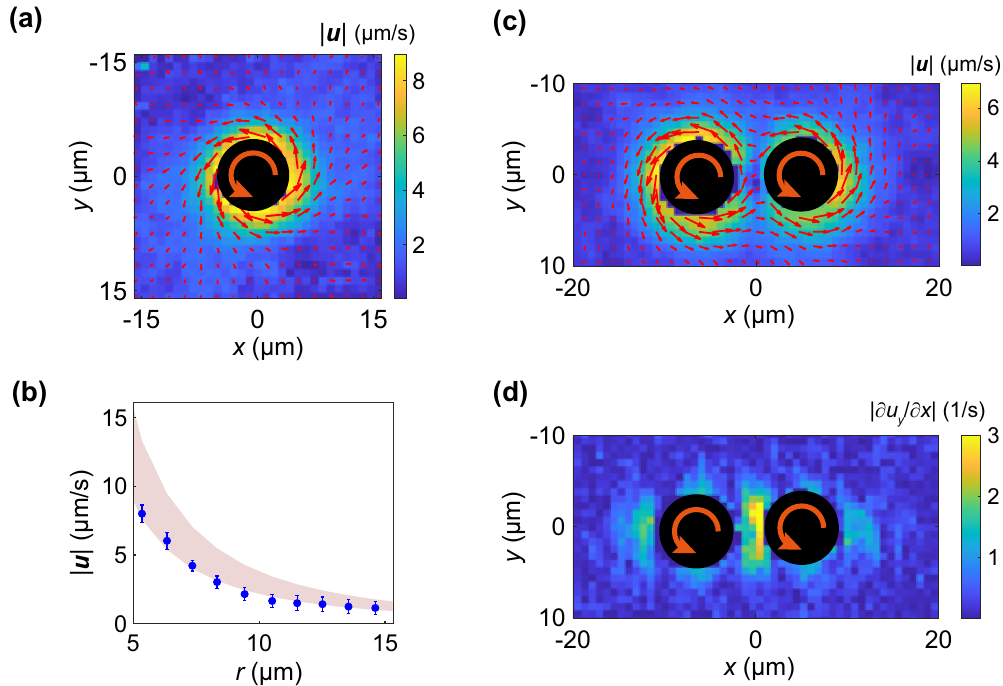
Figure 3. Flow field induced by NLC droplet rotators. ( a ) Velocity field generated by rotation of single NLC(E7) droplet with radius of 3.6 ± 0.3 µm. The arrows represent local velocity vector. The laser power used was 29 mW. ( b ) Variation in azimuthal component of induced velocity field u in ( a ) with distance r from center of rotating NLC droplet. The shaded area shows the range of the velocity estimated using Eq. (6). ( c ) Induced velocity field u for two rotating NLC droplets with 36 mW laser power. The arrows represent local velocity vectors. ( d ) Shear ∂ u y rate of flow velocity in y-direction ∂ x evaluated from ( c